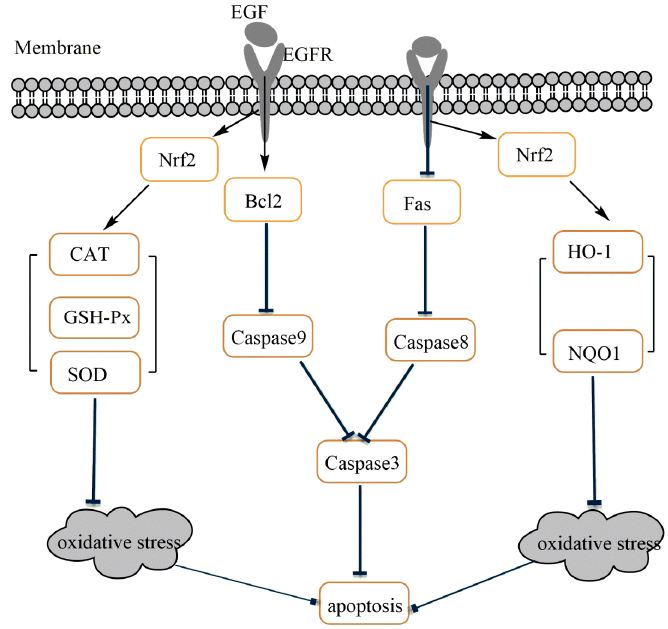
Figure 8. Possible mechanism of EGF on the regulation of oxidative stress-induced apoptosis in IPEC-J2 cells.